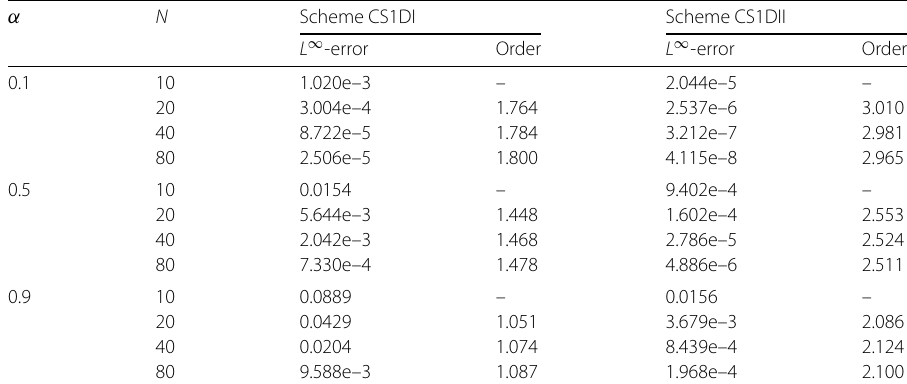
Table 4 Numerical comparison results of schemes CS1DI and CS1DII for Example 2, at T = 1 with N x = 2000 and different N and α